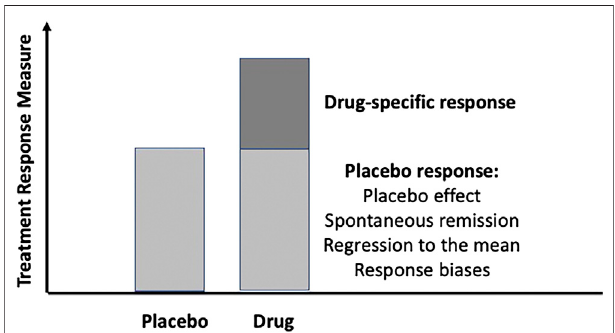
FIGURE 1 | The conventional model of the placebo response in randomized,placebo-controlledtrials(RCT):Itisassumedthatinthedrugarm of the RCT, the placebo response is equal to its size in the placebo arm. In both, the effects of the spontaneous course of symptoms, methodological effects such as the “ regression to the mean, ” and responses biases contribute to its size, in addition to the placebo effect, which is the individual response of a patient towards placebo